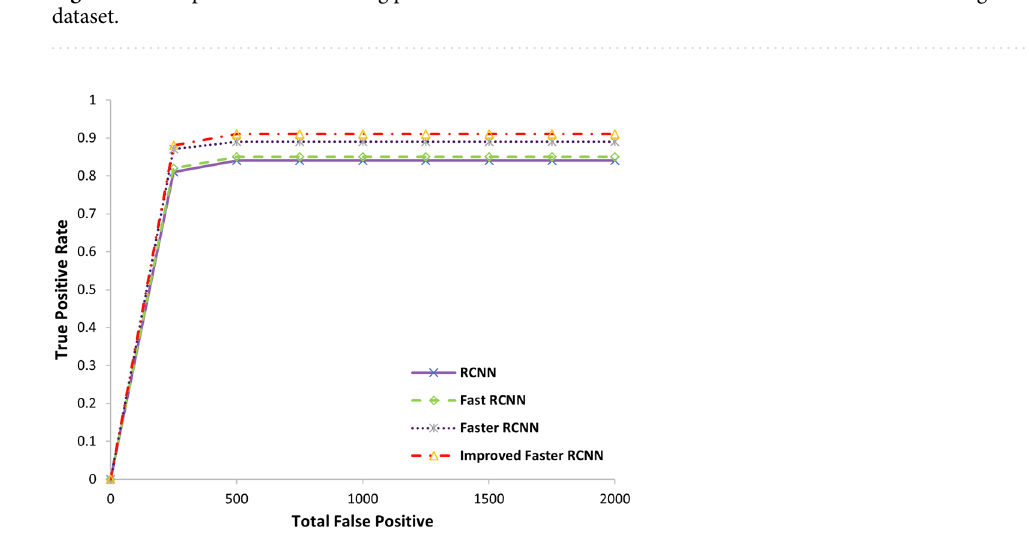
Figure 6. Comparison of faster RCNN with RCNN and Fast RCNN on our used industrial image